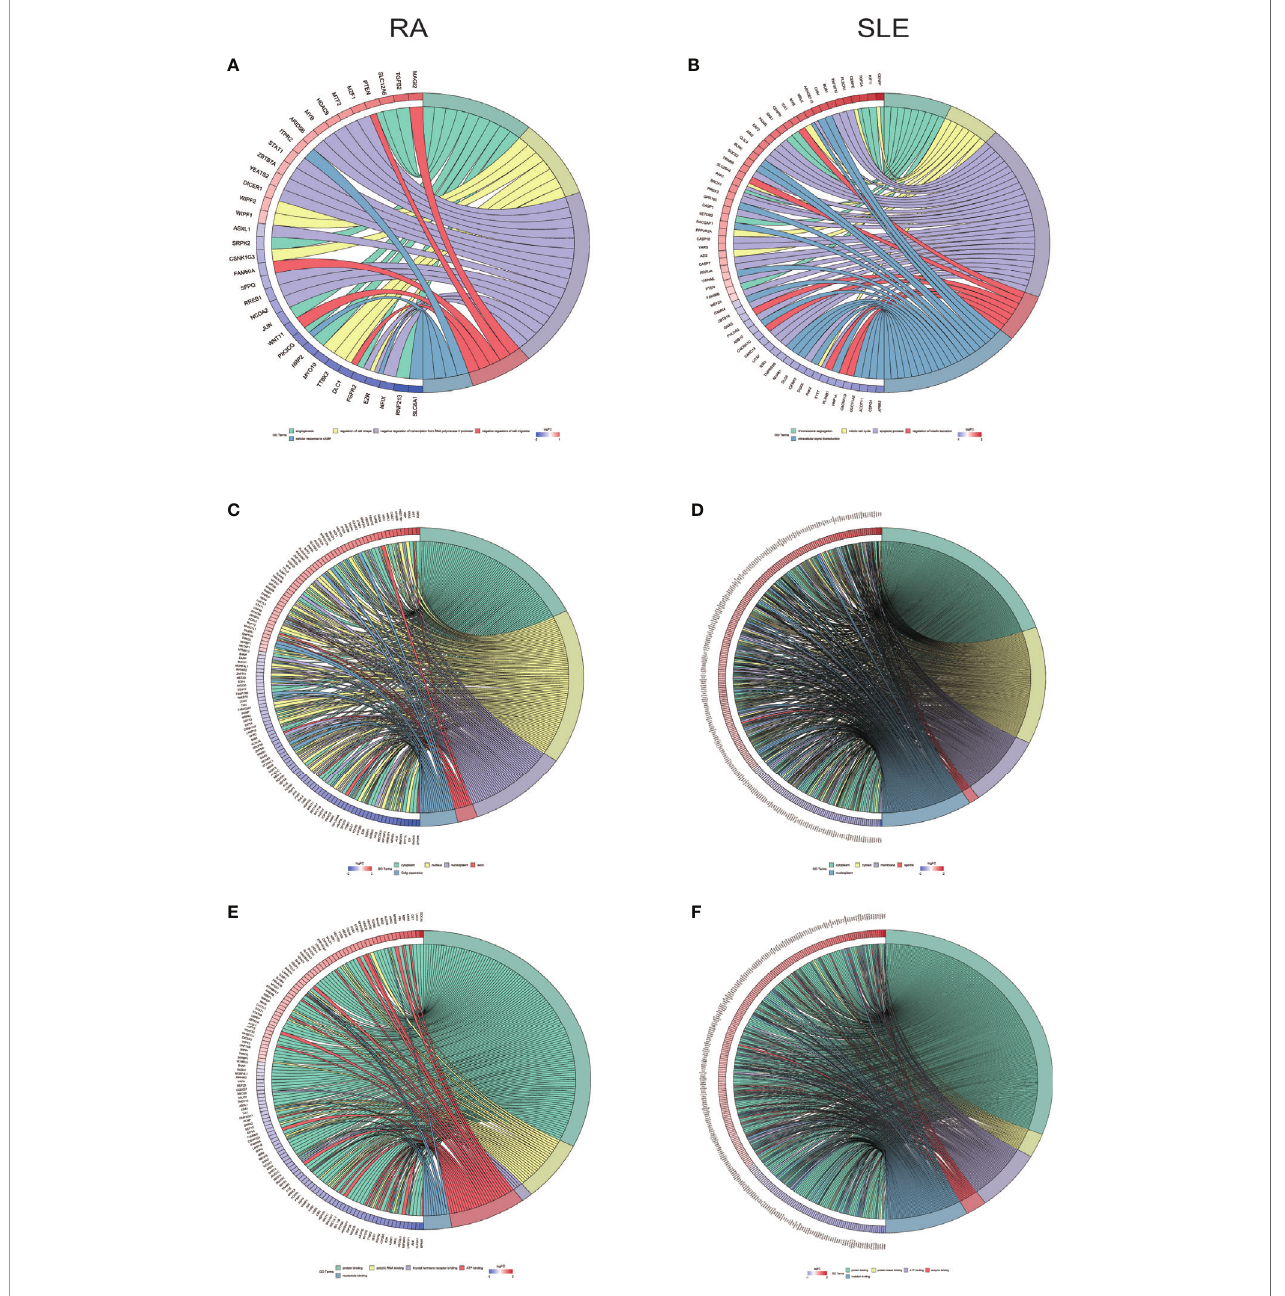
FIGURE 6 | Chordplotdepicting the relationship between aberrantly methylated DEGs ofCD4 + T cells between RA and SLE. (A) Top5 GO terms of biological process in RA and (B) SLE; (C) Top5 GO termsofcellular components inRA and (D) SLE; (E) Top 5 GO terms of molecular functionsinRA and (F) SLE. GO,gene